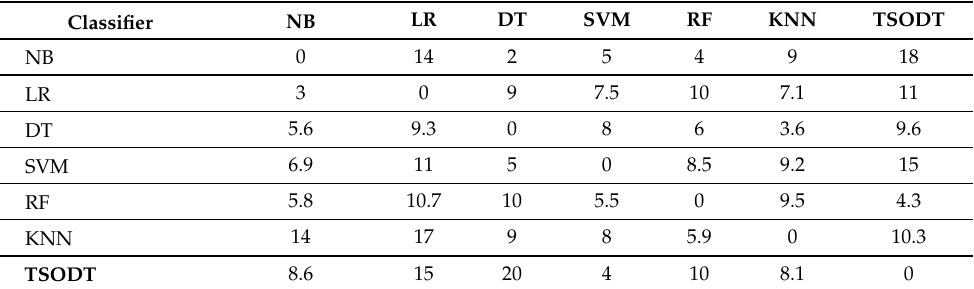
Table 4. Results using post hoc analysis.